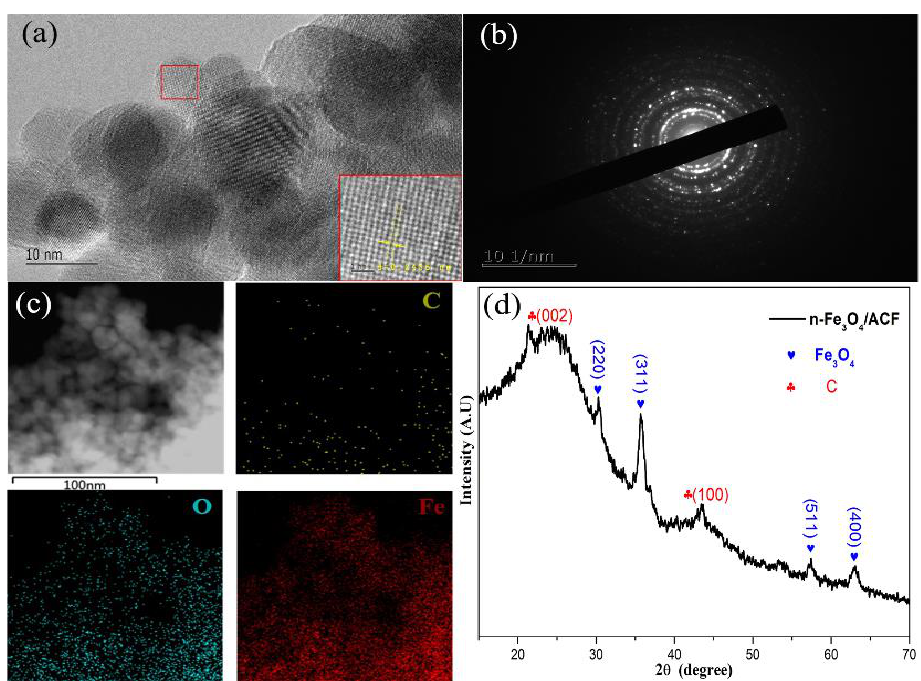
Figure 2. ( a ) TEM image and interplanar spacing of n-Fe 3 O 4 /ACF; ( b ) electron diffraction image of n-Fe 3 O 4 /ACF; ( c ) TEM image and corresponding element maps of n-Fe 3 O 4 /ACF; ( d ) XRD spectrum of n-Fe 3 O 4 /ACF.